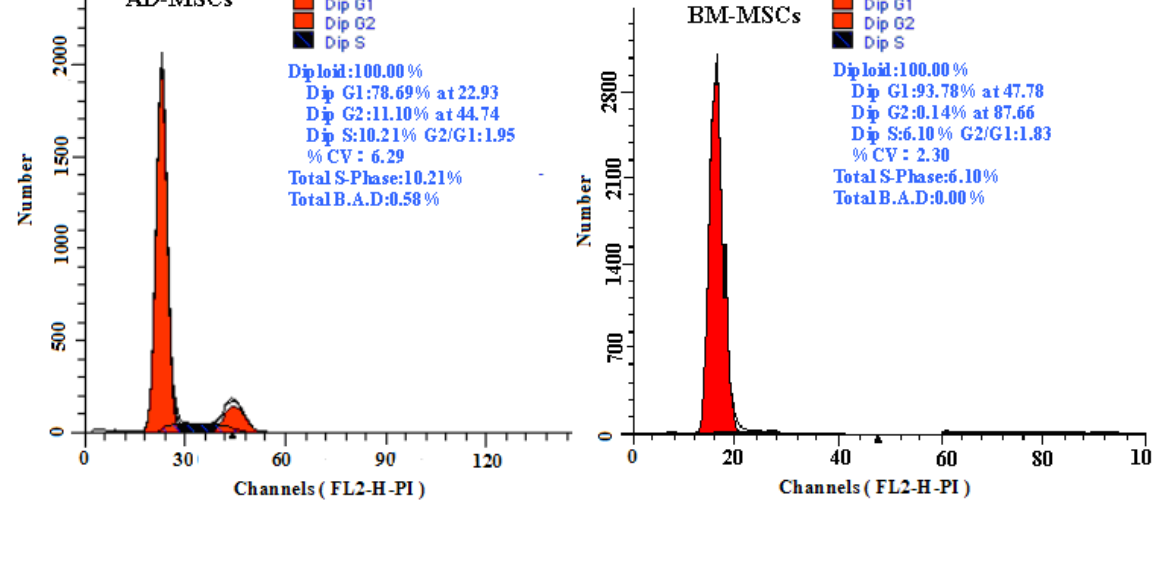
Figure 3. The DNA content of AD-MSCs and BM-MSCs by flow